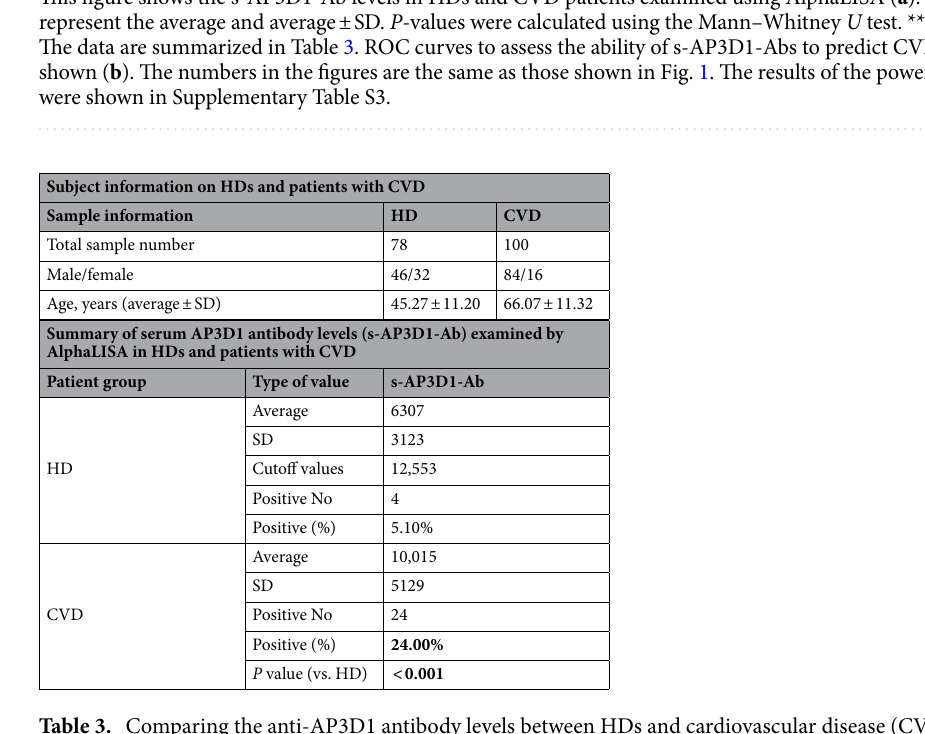
Table 3. Comparing the anti-AP3D1 antibody levels between HDs and cardiovascular disease (CVD) patients. The upper panel indicates the number of total samples, samples from male and female participants, and ages (average ± SD). The lower panel summarizes the s-AP3D1-Ab levels examined using AlphaLISA. Numbers are as shown in Table 1; P -values of < 0.05 and positive rates of > 10% are marked in bold font. The plots for these data are shown in Fig.